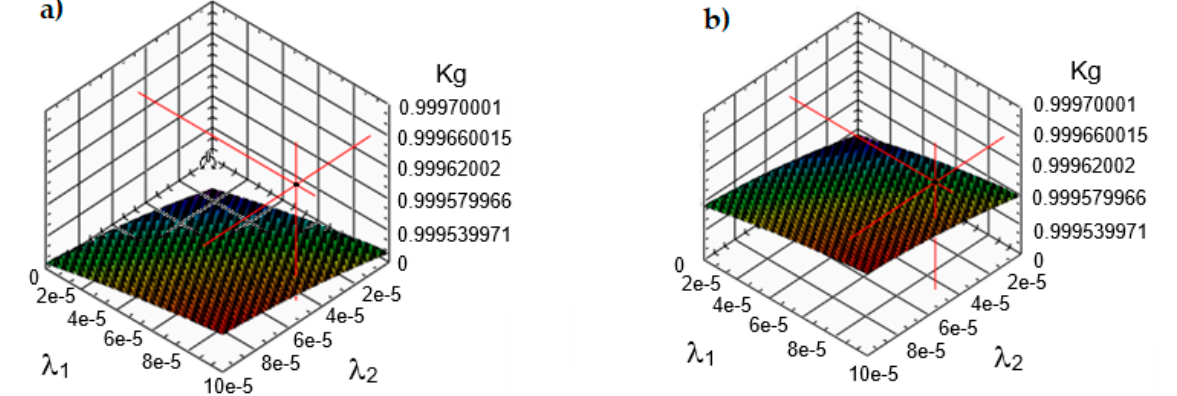
Figure 10. Graphs of the test of the mean time between successive failures, for constant parameters,